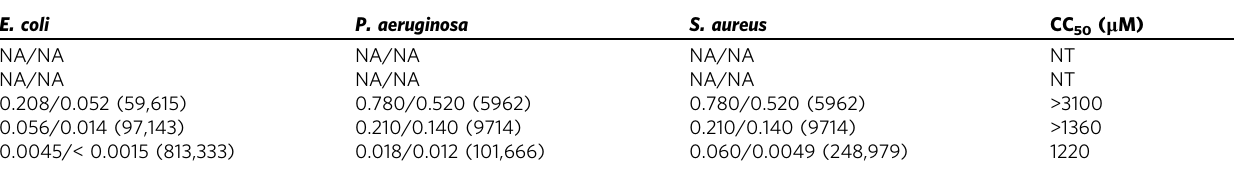
Minimal inhibitory concentrations (MIC) and 50% inhibitory concentrations (IC 50 ) for Escherichia coli ( E. coli ), Pseudomonas aeruginosa (P. aeruginosa) , and Staphylococcus aureus ( S. aureus ). Cytotoxic concentrations (CC 50 ) were evaluated in lung epithelial A549 cells. The selectivity index (SI), calculated as CC 50 /IC 50 , is indicated in parentheses next to the IC 50 . β -Cyclodextrin ( β CD), 2- β - cyclodextrin-arginine ( β CD-arg), 3-cipro fl oxacin (cpx), 4- β -cyclodextrin-cipro fl oxacin ( β CD-cpx), and 5- β -cyclodextrin-arginine-cipro fl oxacin ( β CD-arg-cpx). NA no detected activity, NT